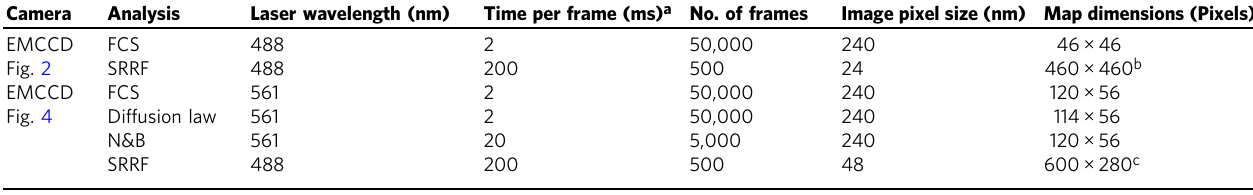
Table 3 Acquisition parameters for the various experimental con fi